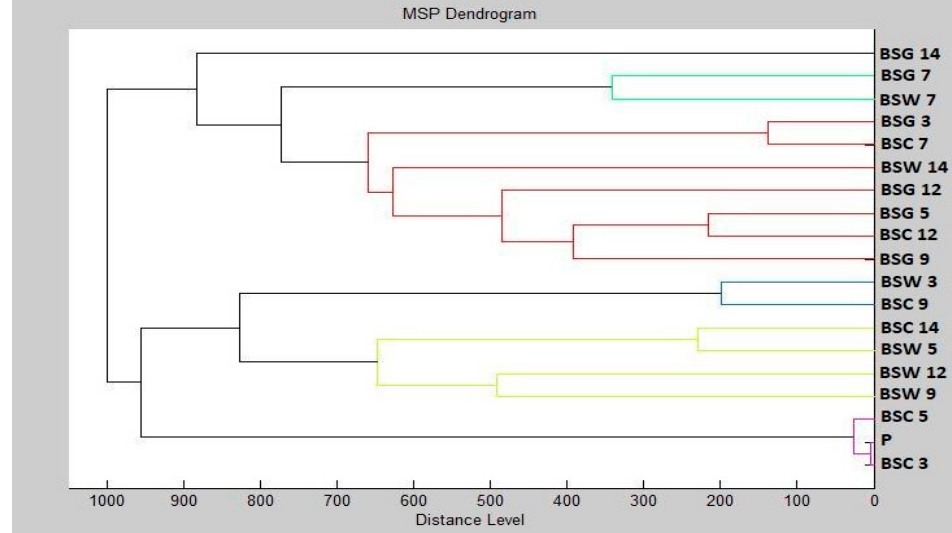
Figure 2. Dendrogram of B. subtilis generated using MSPs of the planktonic cells and the control. BS, B. subtilis ; C, control; G, glass; W, wood; and P, planktonic cells .